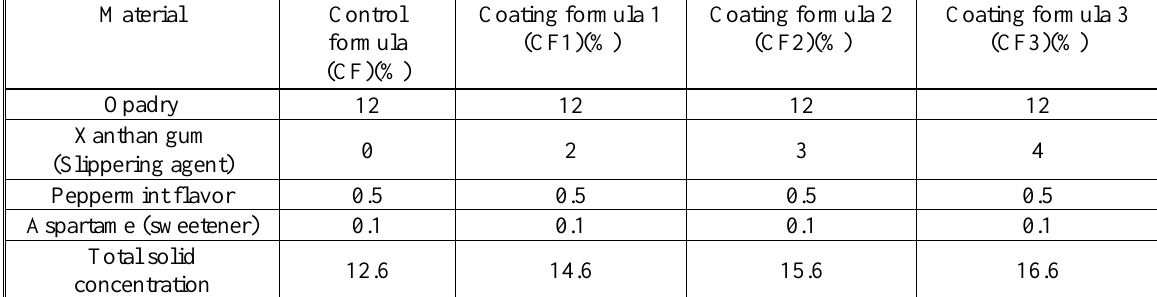
Table 3. The experimental design and formulas of the slippering